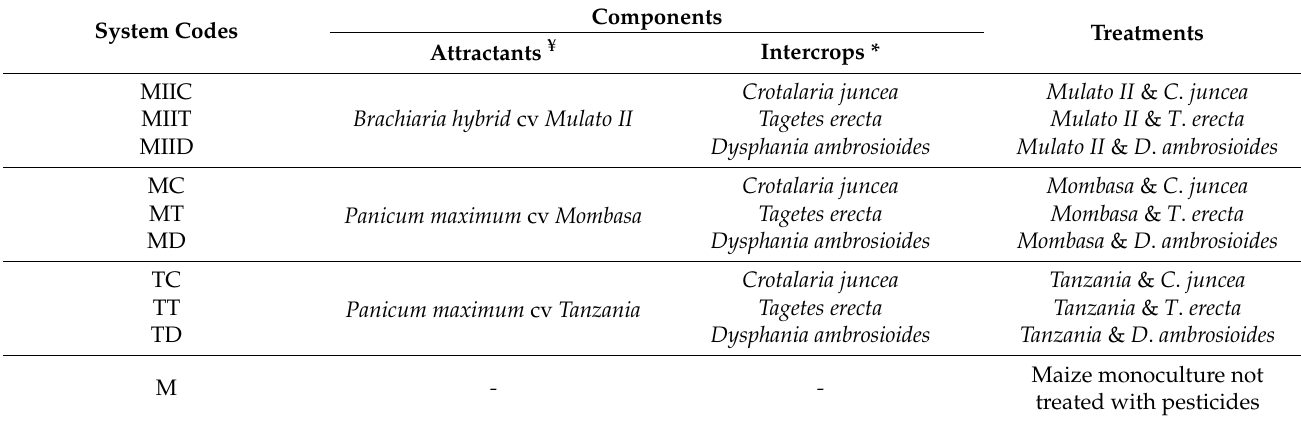
Table 1. Fall armyworm management systems tested in maize crops in Yautepec, Morelos, Mexico.